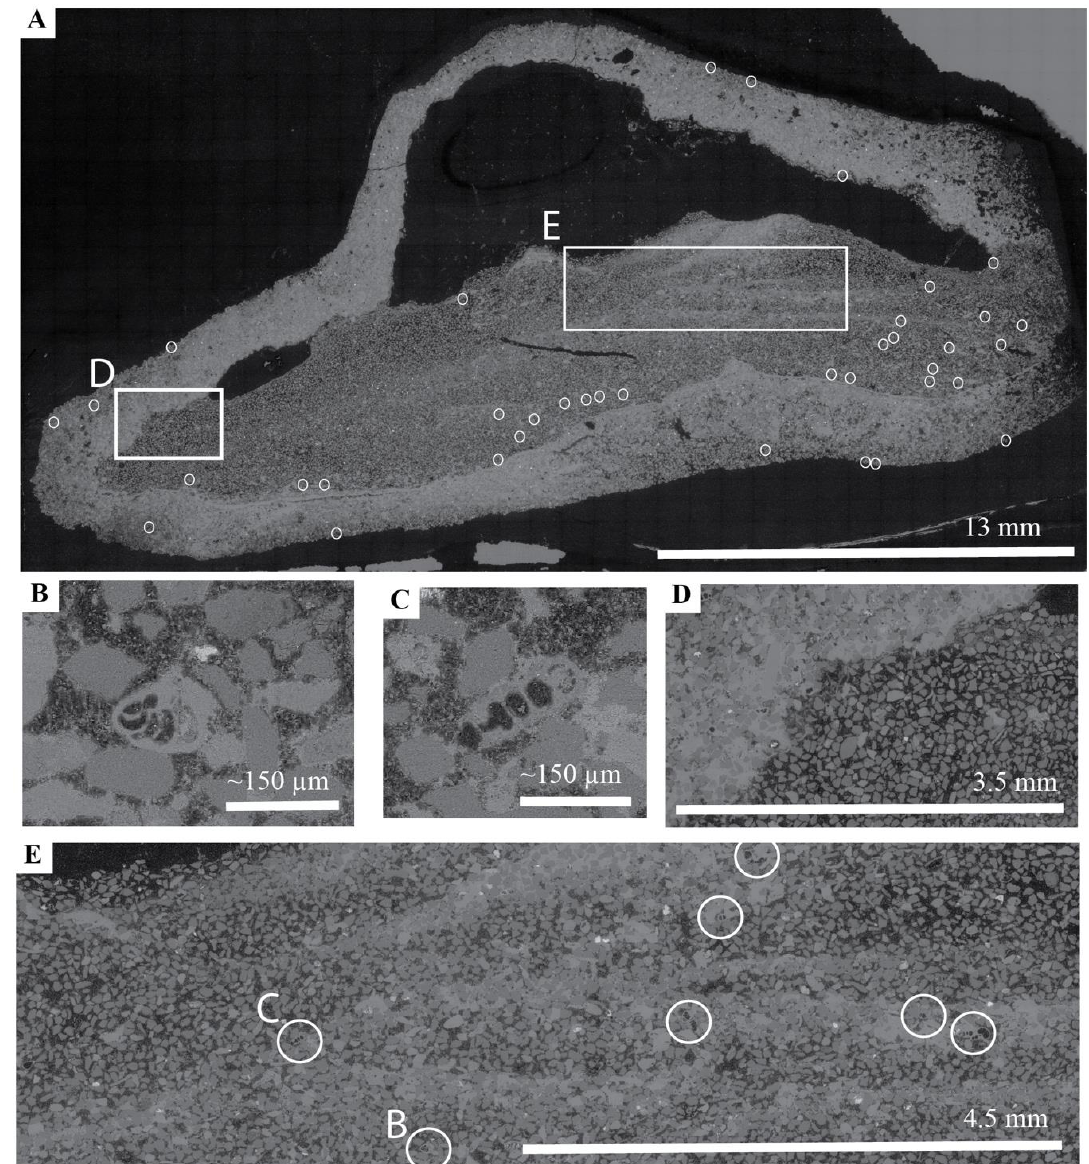
Figure 4. Backscattered electron (BSE) micrographs of hardground features and fabric. ( A ) Montage of open horizontal burrow system ( Thalassinoides ), partially infilled with sediment. Note that the burrow is surrounded by a well-cemented halo. ( B , C ) Foraminifera from sediment within burrow. ( D ) Detail of wall-burrow interface, illustrating stark contrast in degree of cement. ( E ) Section of sediment within burrow illustrating alternating laminae of well-cemented and poorly-cemented. Additionally, areas of pyrite (bright areas). Note in all images, pores appear black. Open circles in ( A , E ) represent the location of calcaceous microfossils (mostly foraminifera). Table 1. Composition (X-ray diffraction (XRD)), ∂ 13 C ‰ V-PDB, ∂ 18 O ‰ V-PDB and temperature, for biological calcite and aragonite cement from the Rathlin sample. Analytical precision ± 0.1‰. Temperature calculated based on Epstein et al. [17]: T = 16.5−4.3 δ + 0.14 δ 2 ; T = temperature in ˚C, and